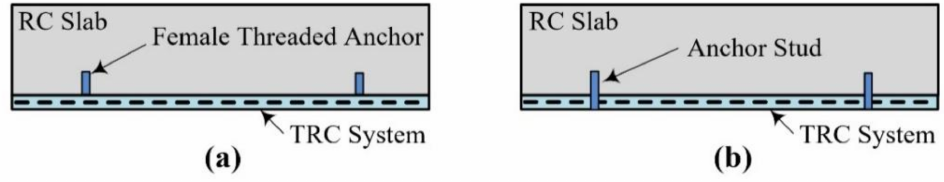
Figure 11. Anchor stud within TRC system: ( a ) anchors removed (NA specimen); ( b ) anchors remained (LS75, LS150, RRC, and RSG specimens).